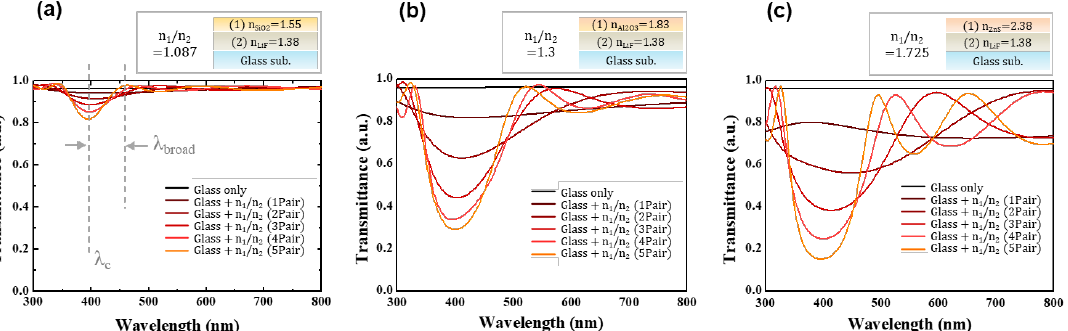
Figure 2. Effect of dielectric one-dimensional photonic crystals (1DPhCs). Transmission spectra of 1DPhCs formed on the glass substrate and containing different dielectric materials: ( a ) LiF and silicon oxide (SiO 2 ); ( b ) LiF and aluminum oxide (Al 2 O 3 ); and ( c ) LiF and zinc sulfide (ZnS). All graphs show the spectral changes according to the numbers of layers.